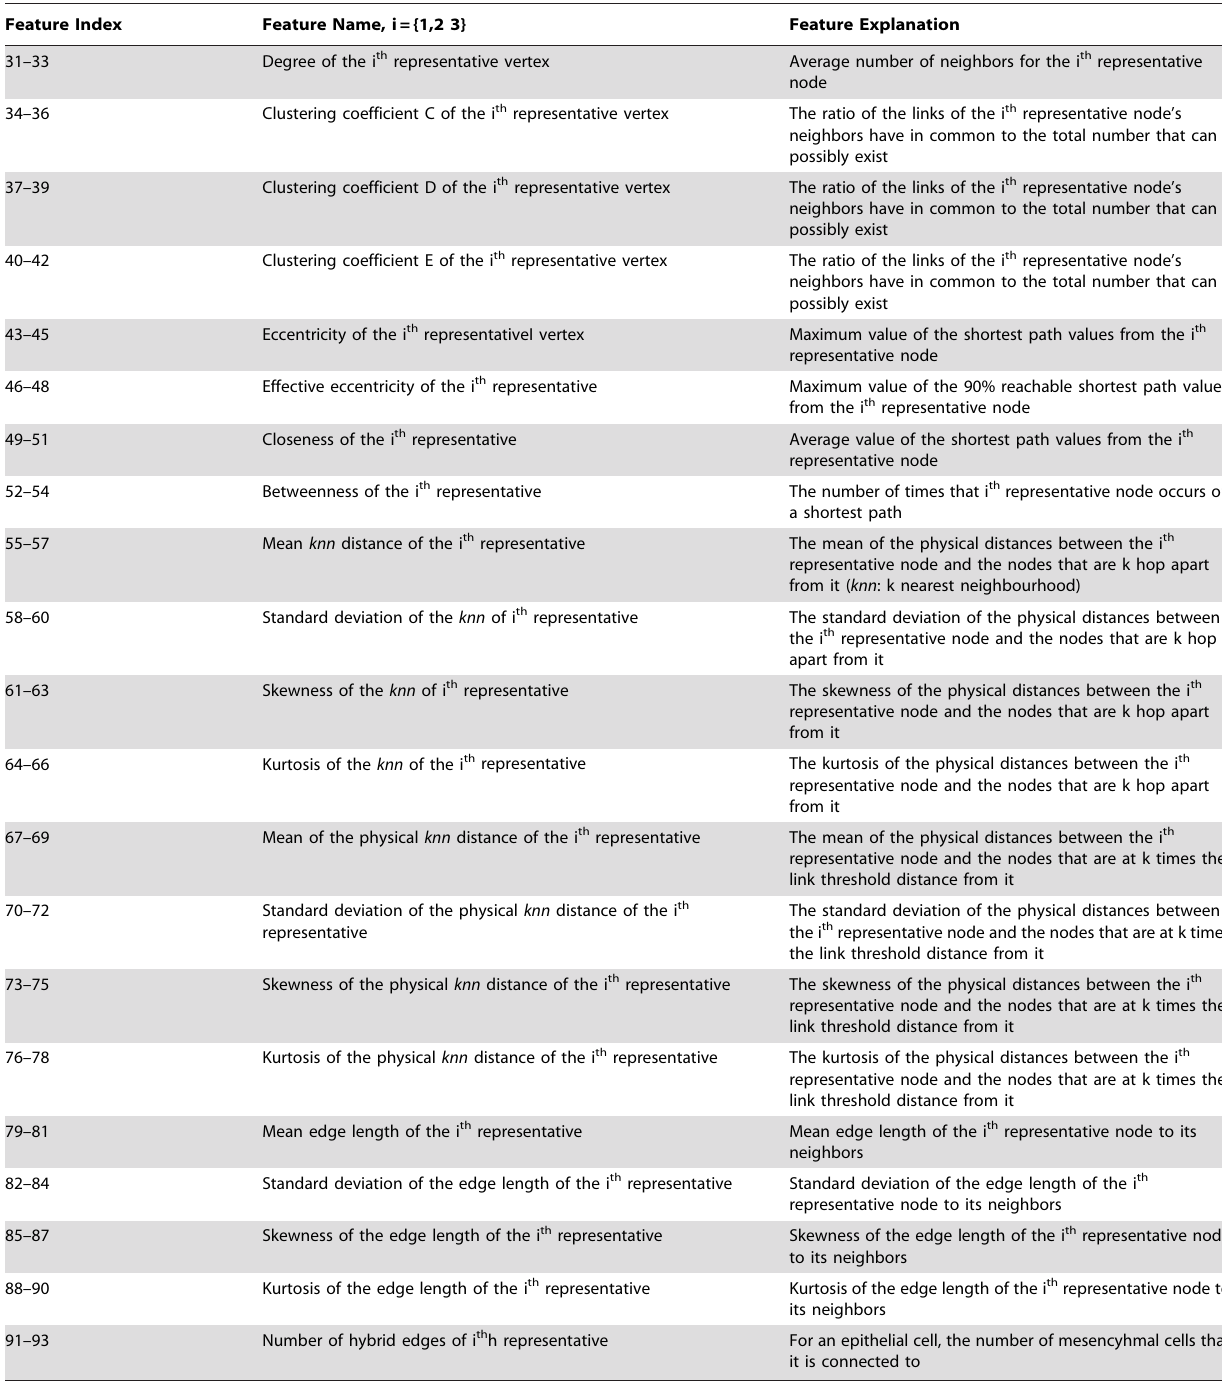
Table 3. Local structural